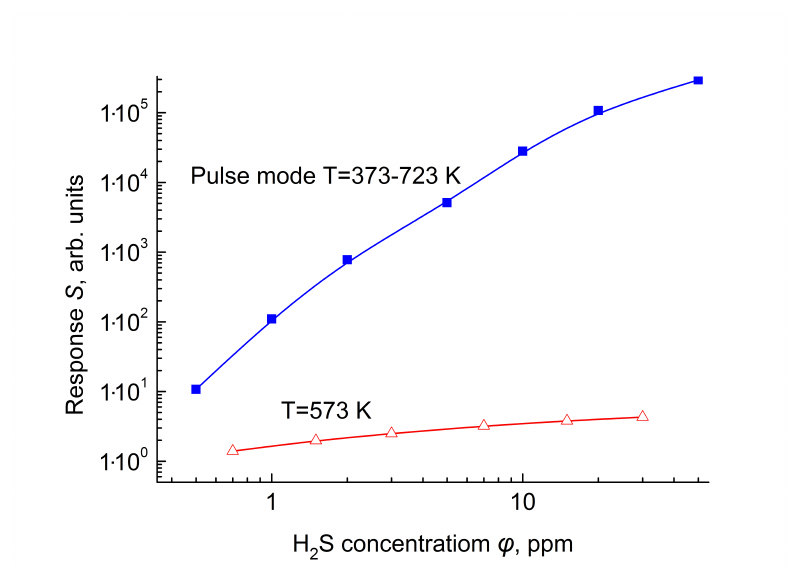
Figure 12. Sensor response as a function of H 2 S concentration for constant and modulation temperature